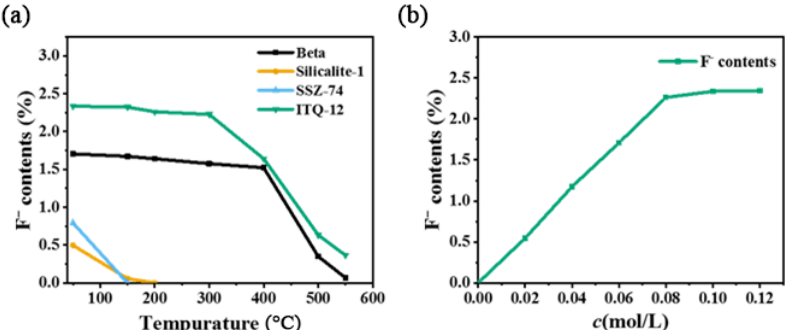
Figure 1. ( a ) Fluoride contents of Beta, Silicate-1, SSZ-74, ITQ-12 after heated at different temperature; ( b ) Fluoride contents of ITQ-12 F − loaded in different concentrations of NH 4 F-methanol solution.